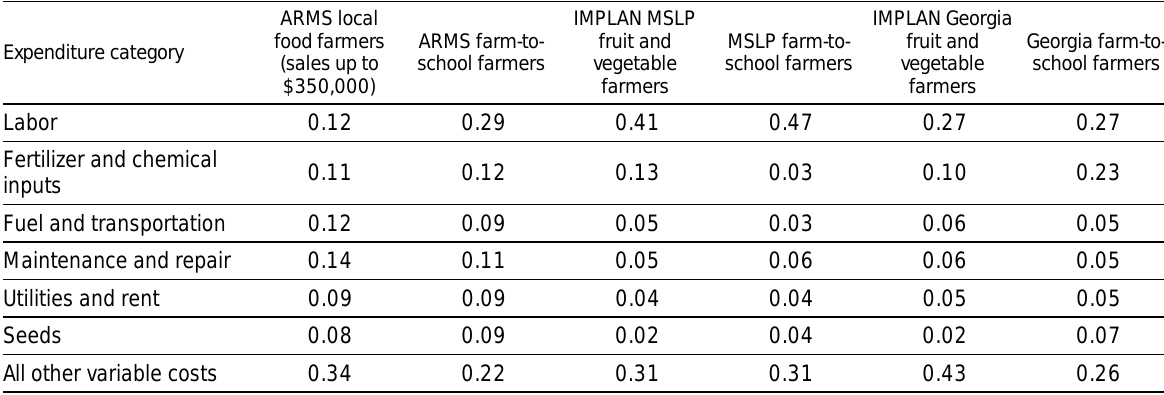
Table 3. Share of Variable Costs Attributed to the Top Six Expenditure Categories